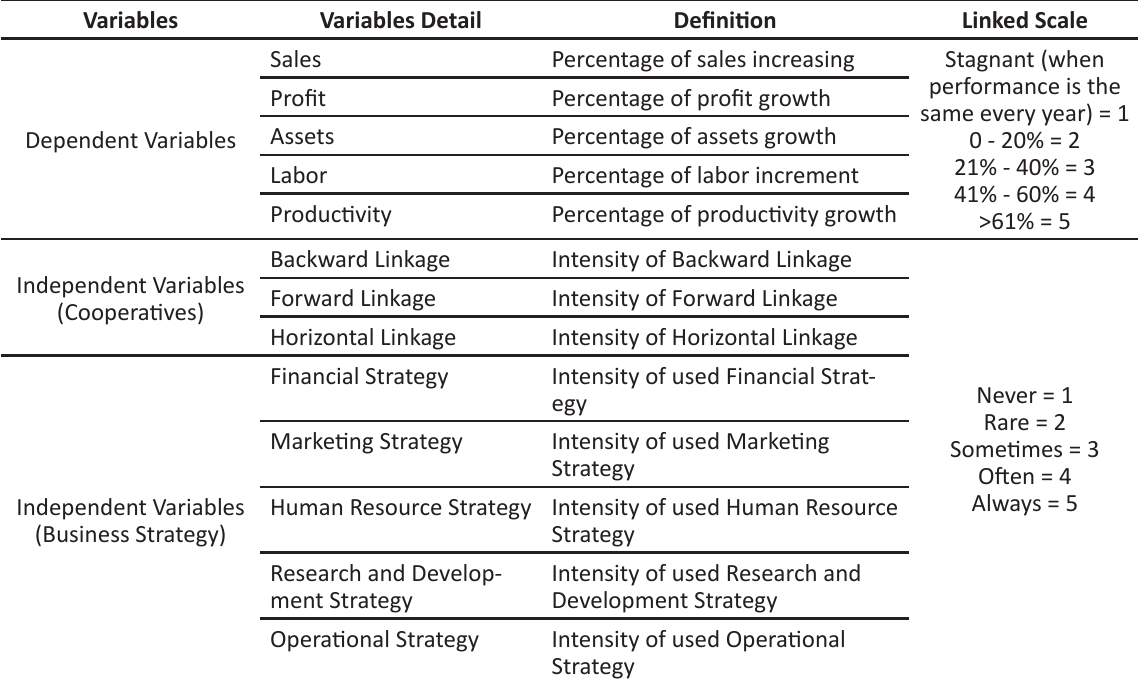
Table 1: Operational Definition of